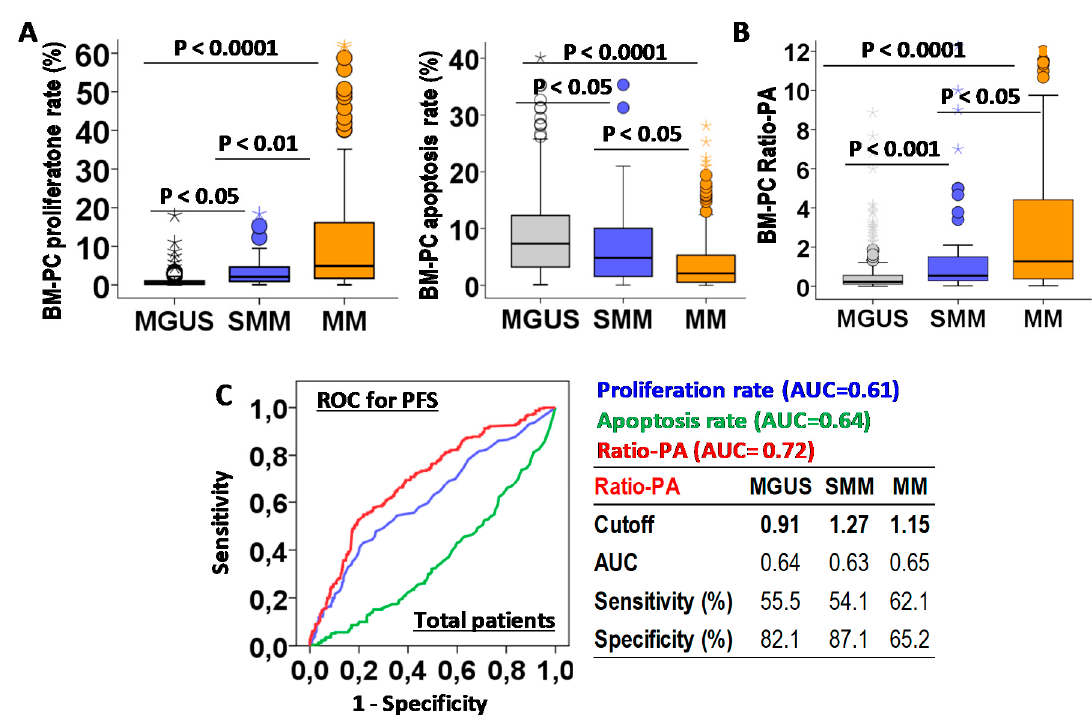
Figure 2. Biological characteristic of bone marrow plasma cells (BM-PCs) in patients with monoclonal gammopathy of undetermined significance (MGUS), smoldering multiple myeloma (SMM), or multiple myeloma (MM) and their prognostic capacity for progression-free survival (PFS) . ( A ) Quantification of BM-PCs proliferation and apoptosis rates in MGUS, SMM, and MM patients. ( B ) Proliferation-to-apoptosis ratio (Ratio-PA) of BM-PC in MGUS, SMM, and MM. ( C ) Receiver-operating characteristic (ROC) analysis of proliferation and apoptosis rates and Ratio-PA for PFS in total patients. Table shows cutoff values with maximum prognostic capacity for PFS, area under the curve (AUC), sensibility, and specificity of Ratio-PA in MGUS, SMM, and MM patients.